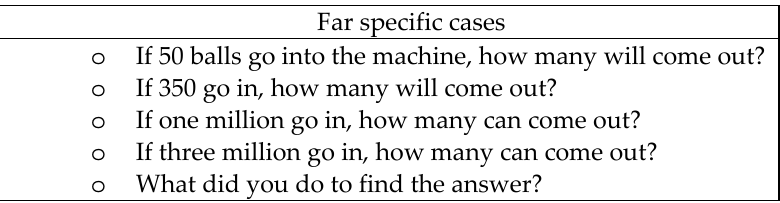
Figure 7. Far specific cases used in the interview.